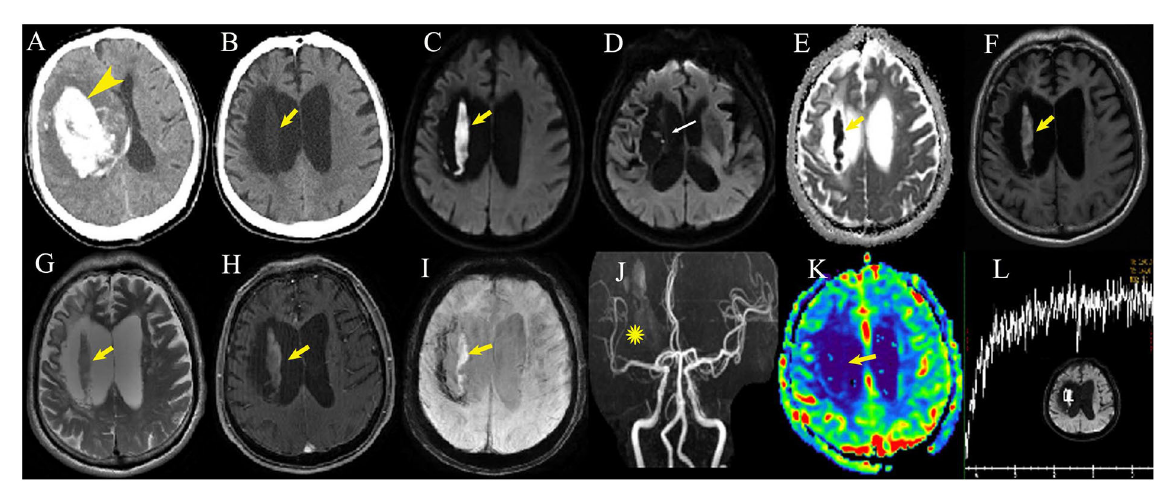
FIGURE2 Multimodal imaging examination of one patient 23 months after intracerebral hemorrhage with surgery (B–L) . A large hematoma can be seen at the basal ganglia in the first CT scan at disease onset ( A , arrowhead). Post-surgery CT scan displays low density ( B , arrow) in the corresponding MRI DWI hyperintense lesion ( C , arrows) within the hematoma cavity adjacent to the cavity wall. The cavity wall close to the lateral ventricle is very thin ( D , thin arrow). The apparent diffusion coefficient sequence shows the dark area in accordance with the DWI hyperintensity ( E , arrow). T1 fat-suppressed image ( F , arrow), T2-weighted image ( G , arrow) and susceptibility-weighted imaging ( I , arrow) show mild hyperintensity with no contrast enhancement ( H , arrow). MR angiography displays sparse artery branches of the right middle cerebral artery ( J , asterisk) with low-relative cerebral blood volume by perfusion-weighted imaging ( K , arrow). No identifiable spectrum of cerebral parenchyma can be seen by magnetic resonance spectroscopy at the DWI lesion (L)